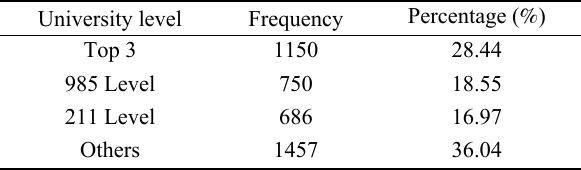
Table 5 Descriptive analysis of university tier factor.